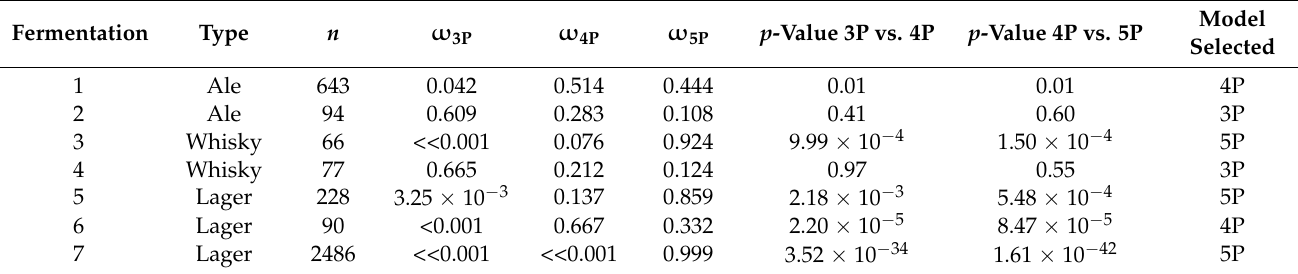
Table 3. Computation of AICc weights ( ω ) and p -values resulting from F-tests of all seven fermentation types. The higher parameterised model incurs a significant reduction in error when p < 0.05. Furthermore, the highest ω presents the model which has the most favourable AICc